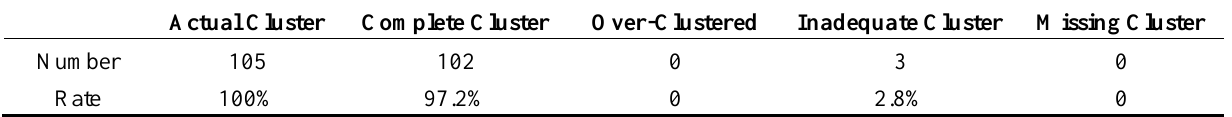
Table 3. Evaluation of the clustering of power line